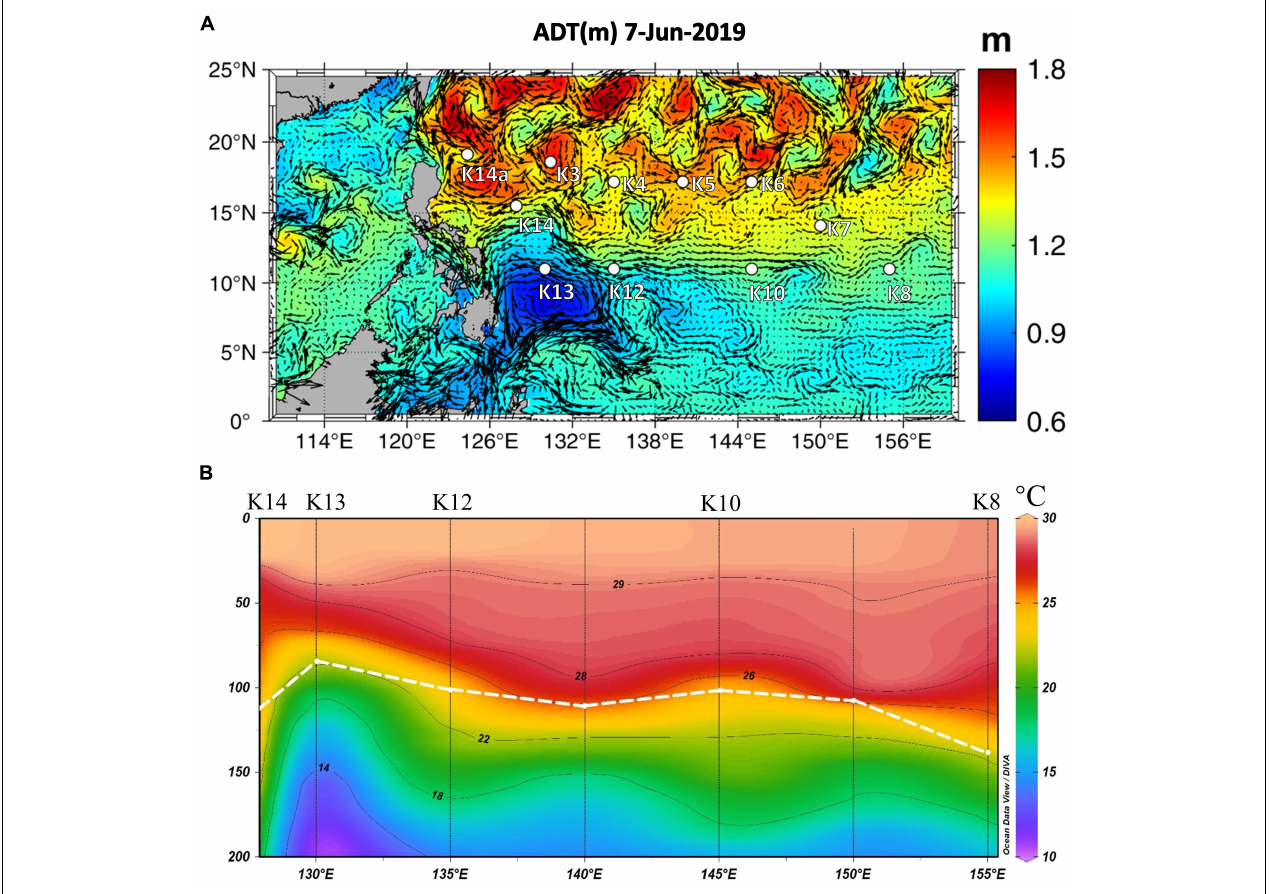
FIGURE 7 | (A) Absolute dynamic topography (ADT) data for time of sampling at station K13 (data downloaded from https://resources.marine.copernicus.eu/). (B) Temperature profile of section from K8 to K14, highlighting upwelling observed at station K13. White dotted line indicates mixed layer